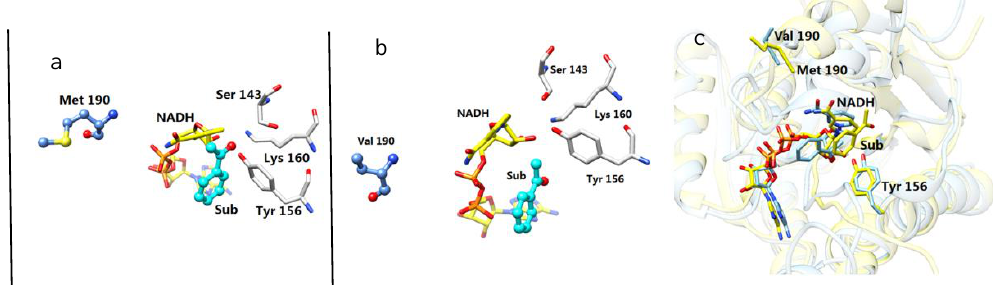
Figure 3. Wild-type EbSDR8-acetophenone complex models. ( a ). Complex models of acetophenone and wild-type EbSDR8. ( b ). Variant M190V-acetophenone complex models. ( c ). Binding pose of the complex models of acetophenone and the wild-type EbSDR8 or variant M190V. The wild-type EbSDR8 complex is shown in gold ribbons, while the variant M190V complex is shown in cyan ribbons.